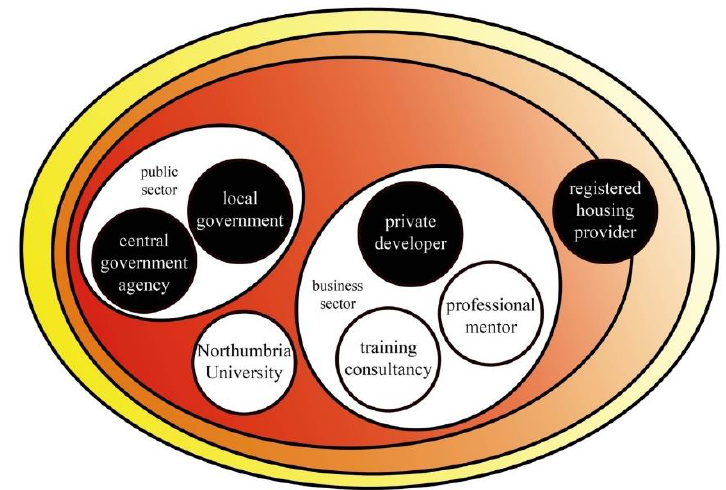
Figure 11. Mapping of Building Pathology Postgraduate Level 7 Module.